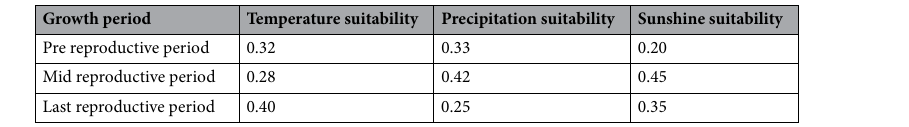
Table 3. The weight coefficients of climatic suitability at each growth